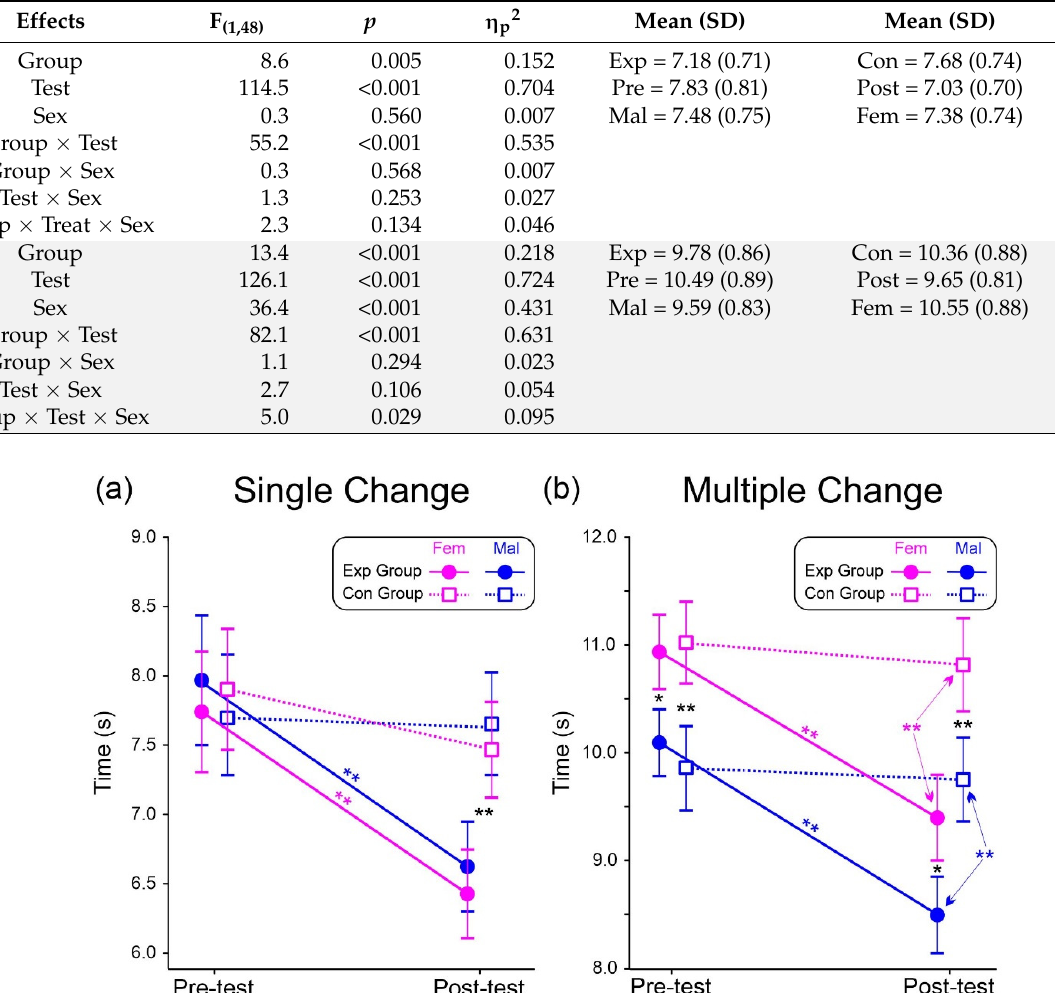
Table 1. Main effects and the interaction of the ANOVA in the basketball tests. The partial eta squared ( η p2 ) is also reported to measure the results power. Mean and standard deviation (SD) of the experimental (Exp), control (Con), males (Mal), and female (Fem) groups, and of the pre-test (Pre) and post-test (Post) are also reported and expressed in seconds. The significant effects are highlighted in red.